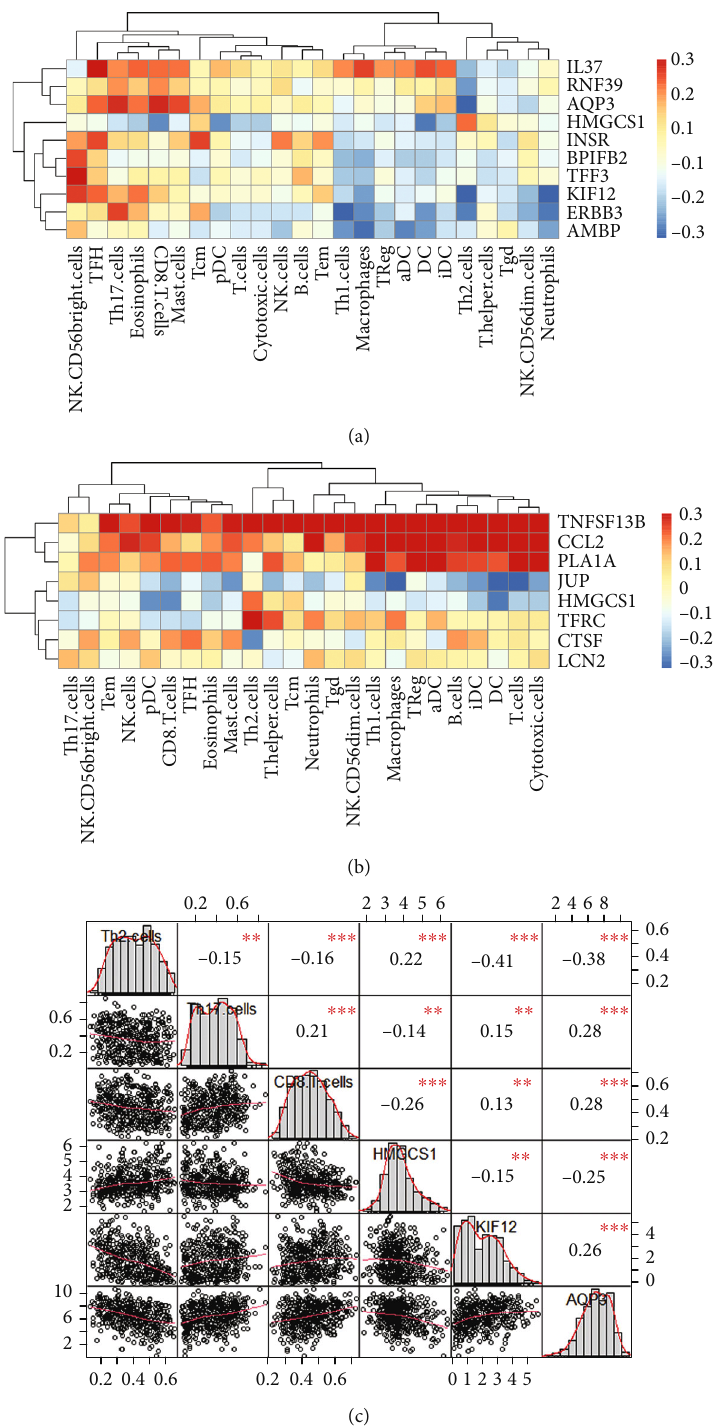
Figure 5: Correlations between secretory or membrane-associated DEGs and immune cells in the tumor microenvironment: (a) correlations between survival-associated DEGs and in fi ltrating immune cells; (b) correlations between DEGs from KRAS subgroups and in fi ltrating immune cells; (c) correlations among Th2, Th17, CD8+ T cell, HMGCS1, KIF12, and